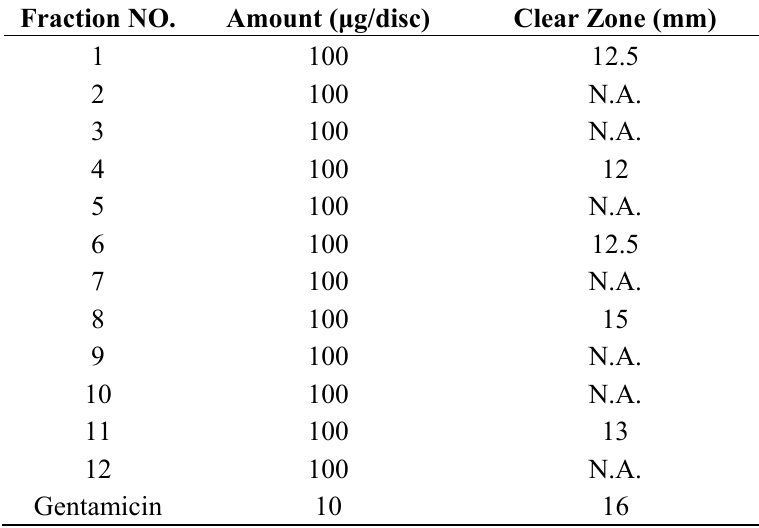
Table 2. Antibacterial activity of fractions isolated by preparative HPLC against P. aeruginosa